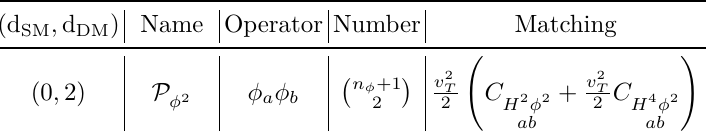
Table 3 . Dimension-two purely DM operator present in DSMEFT and DLEFT. The first column gives the dimensions of the SM and DM part of the operator, the fourth column is the number of operators, and the fifth column is the additional matching contribution at the EW scale. This operator is the φ mass term.